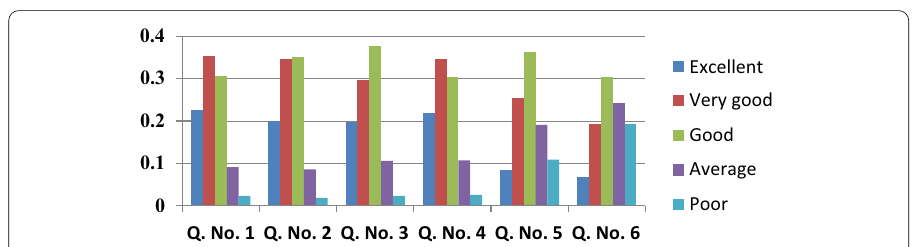
Fig. 2 Graphical representation of effectiveness of library services